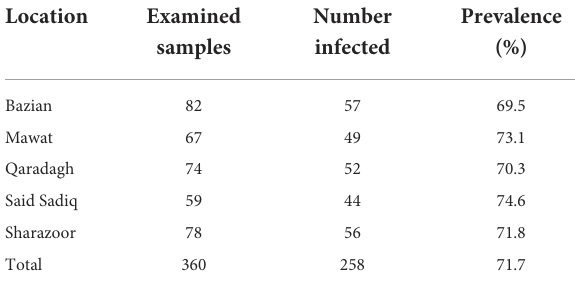
TABLE 1 Occurrence of Theileria spp. in sheep according to regions of the Sulaymaniyah